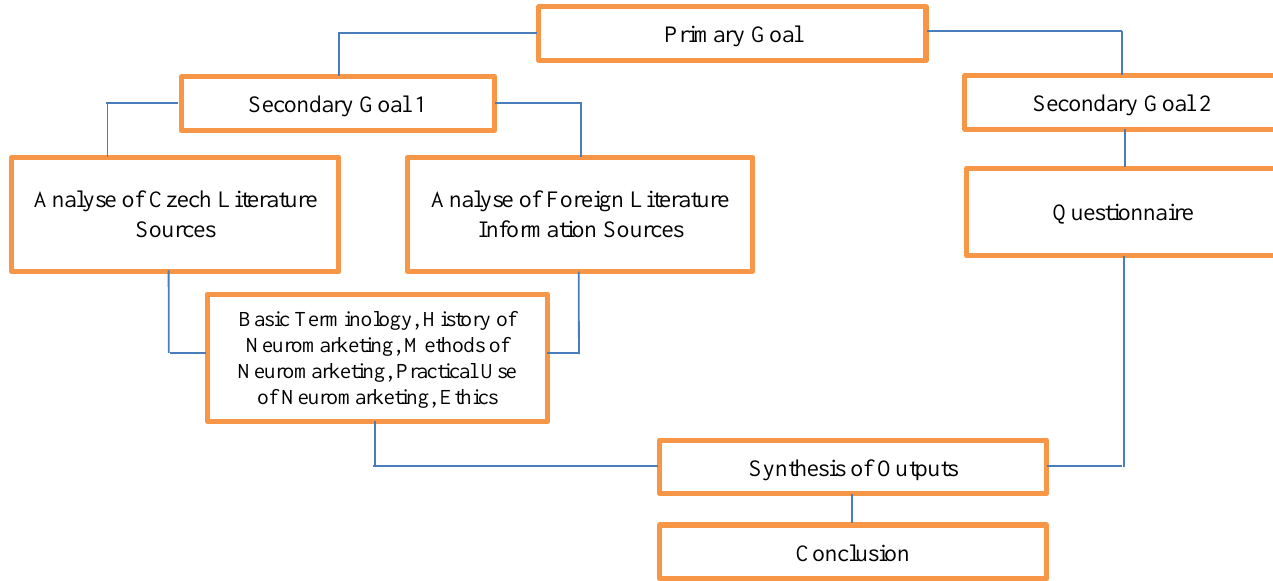
Figure 1. Flowchart of the research methodology